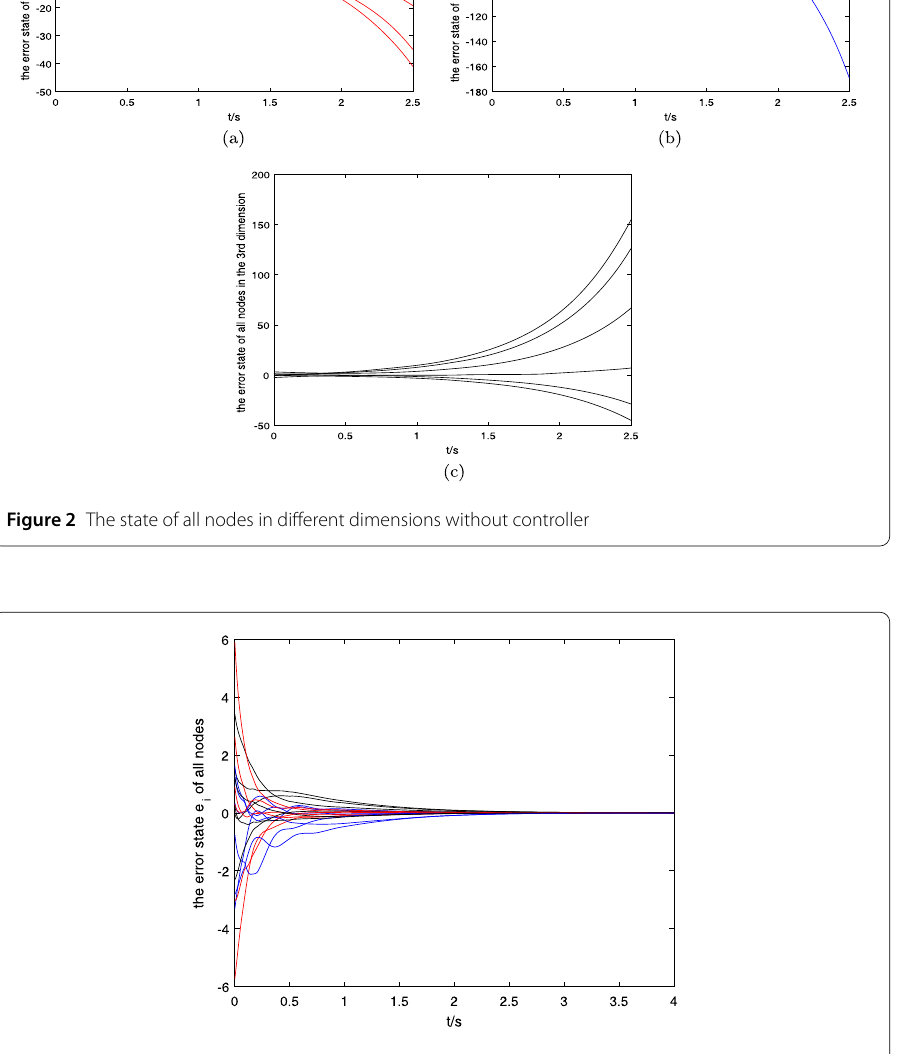
F ( t ) = diag ([ sin ( t ), cos (2 t ), sin (2 t